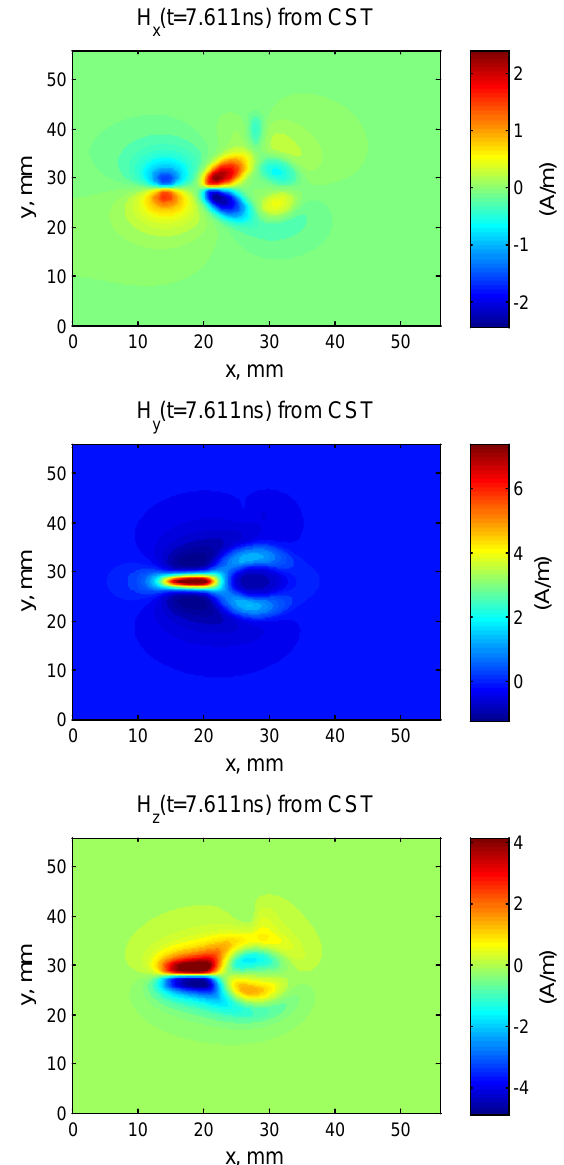
Figure 7: Cartographies of magnetic field components at t =7.611ns obtained from the CST